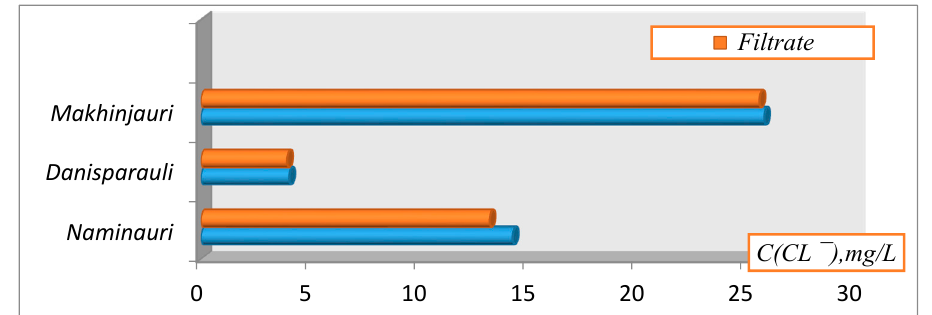
Figure 8. Change in the content of chloride during ultrafiltration of Naminauri and Makhinjauri mineral waters.